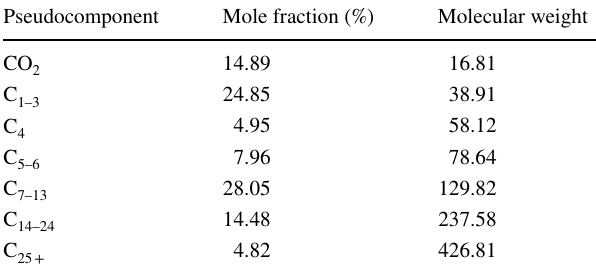
Table 7 Mole fraction and molecular weights of pseudocomponents